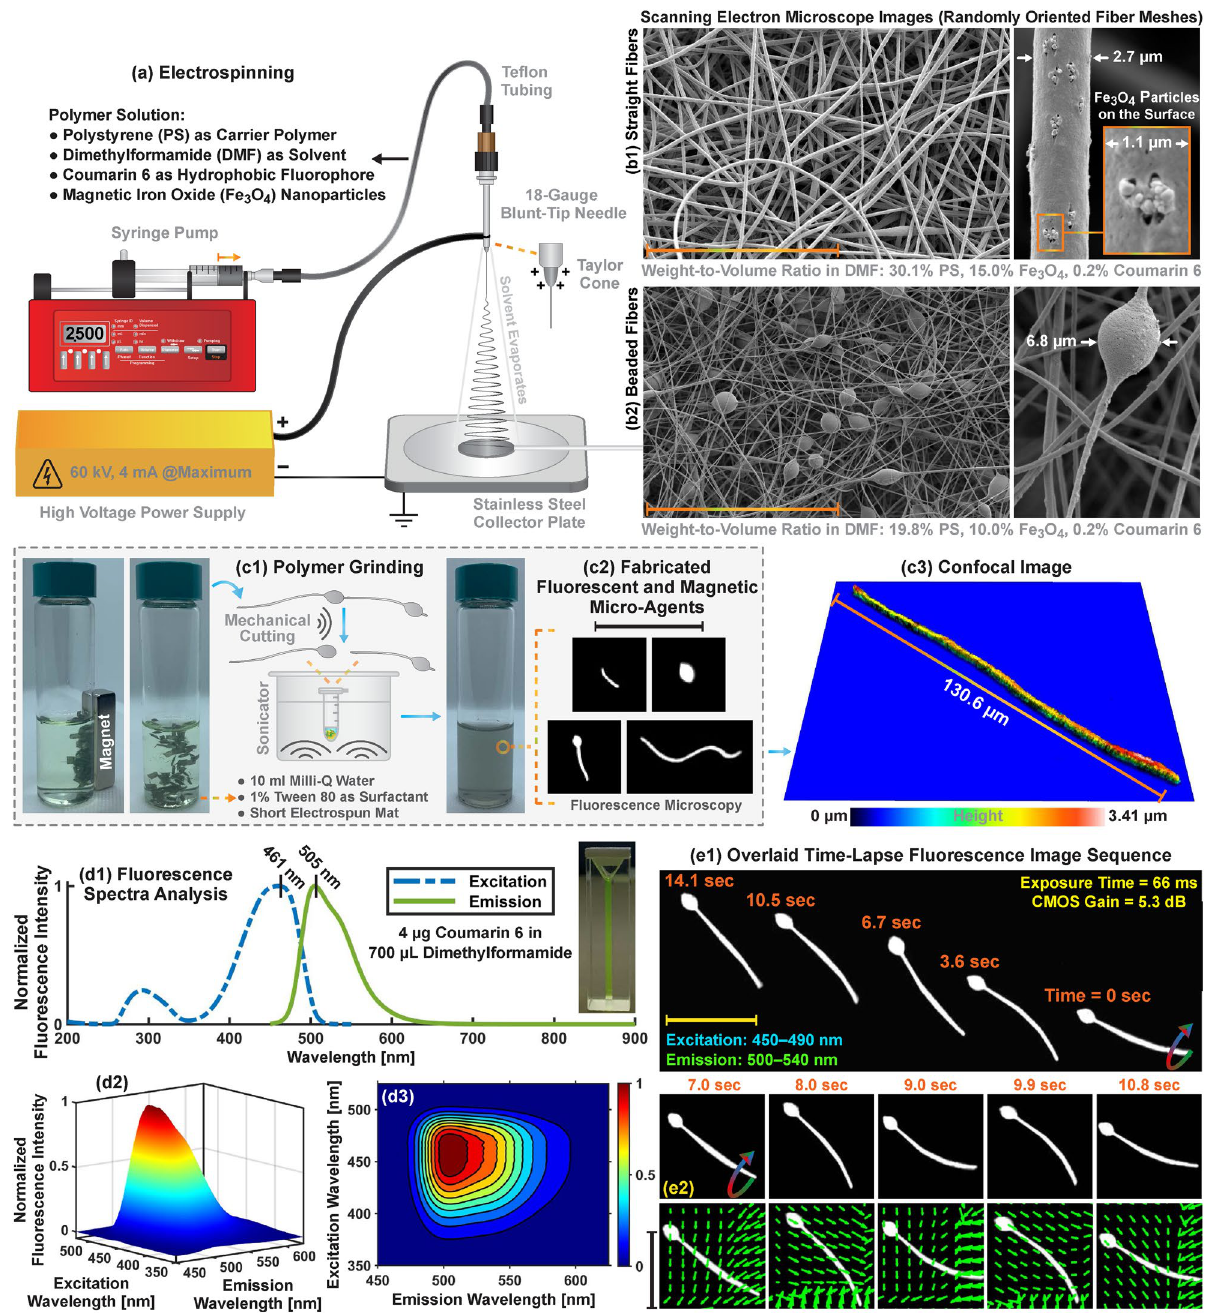
Figure 1. General overview for fluorescent and magnetic micro-agent fabrication using electrospinning. ( a ) Schematic representation of the electrospinning setup and content of the polymer solution. ( b1 ) and ( b2 ) Scanning electron microscope images of the deposited straight and beaded fiber meshes on the collector using electrospinning, respectively. ( c1 ) Polymer grinding process for obtaining micro-agents by cutting the continuous fibers using a sonicator. ( c2 ) Fluorescence images of the fabricated micro-agents. ( c3 ) 3D surface profile of the micro-agent visualized using confocal microscopy. ( d1 ) Ultraviolet-visible spectrum analysis of coumarin-6 in dimethylformamide (DMF). ( d2 ) and ( d3 ) Spectrum analysis of coumarin-6 in DMF at varying excitation and emission wavelengths. ( e1 ) Fluorescence microscopy for visualizing micro-agent movement with a magnetic field of 21 mT. ( e2 ) The vector fields overlaid on the fluorescence images show the motion of the micro-agents analyzed using Lucas–Kanade optical flow. Scale bar 100 µ